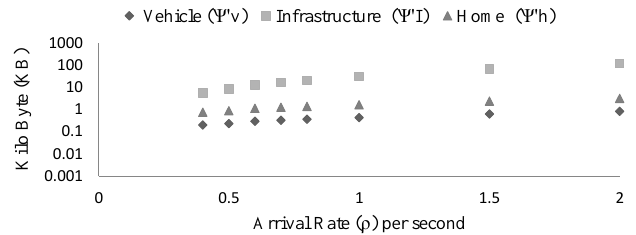
Figure 11. The storage requirements of vehicle, infrastructure and home at various arrival rate ( ρ ) based on the model. Y-axis is measured in log scale of base 10 (thousands unit).